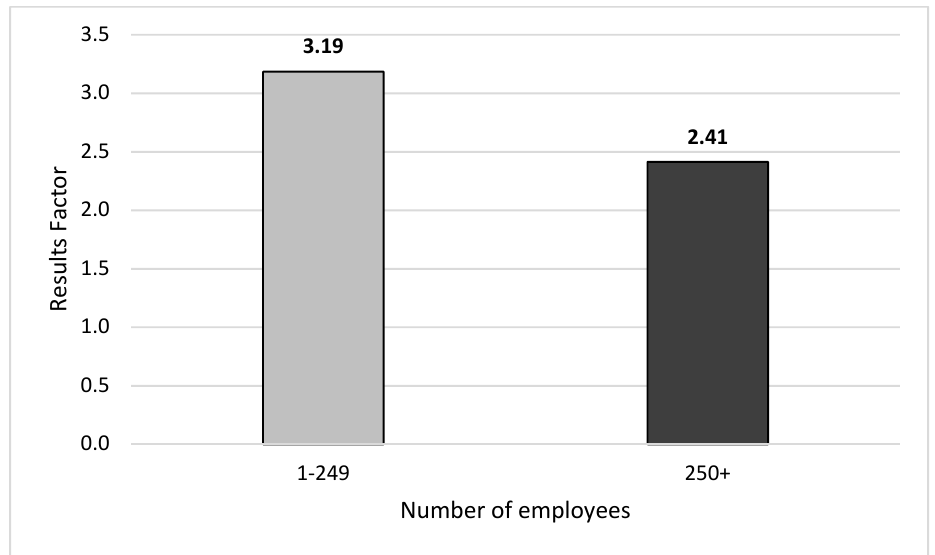
Figure 8. Mean values of results factor in companies employing 1–249 workers and in companies employing at least 250 workers.